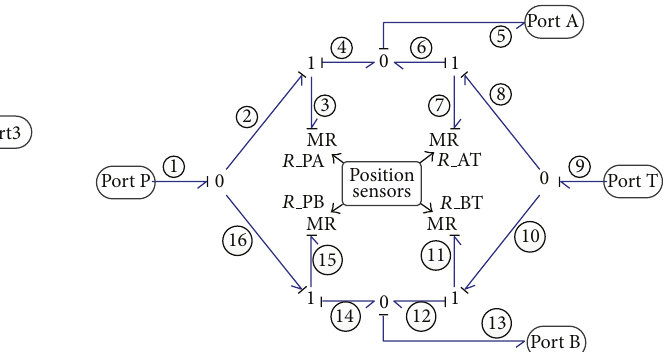
Figure 3: Bond graph model of the variable displacement motor.